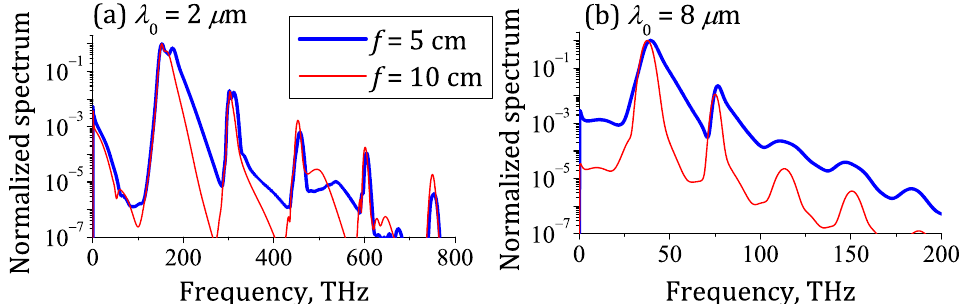
Figure 4. Comparison of the spectra obtained in UPPE simulations at the end of the filament in the Frequency, THz case of 5 cm (blue) and 10 cm (red) focusing of the pulses with the central wavelength of ( a ) 2 µ m and ( b ) 8 µ